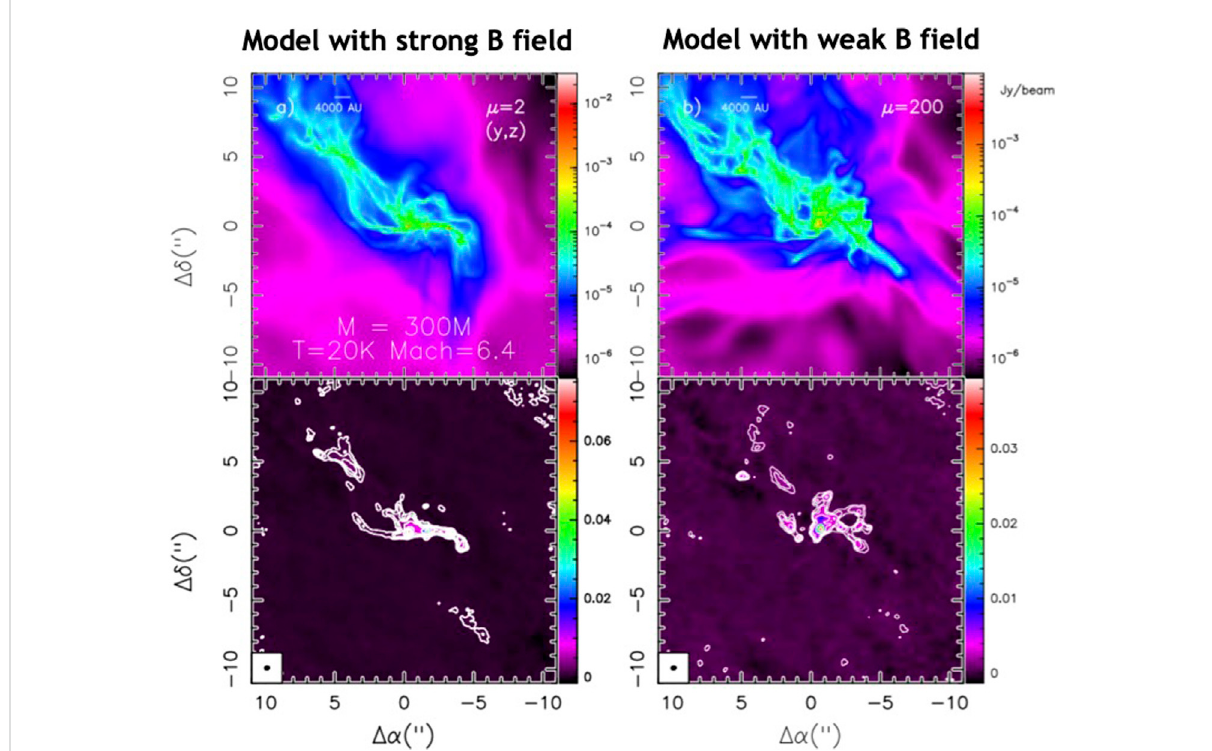
FIGURE 13 Models of the gravitational collapse of a 300 M ⊙ clump, with gas temperature T = 20 K, and Mach number 6.4, from Fontani et al., 2018). Column density maps of two models are shown in the upper row, in the presence of a strong (left) magnetic fi eld and a weak one (right). The lower row shows ALMA synthetic observations of the models using the 280 GHz dust continuum emission. Fewer fragments are seen in the more magnetized